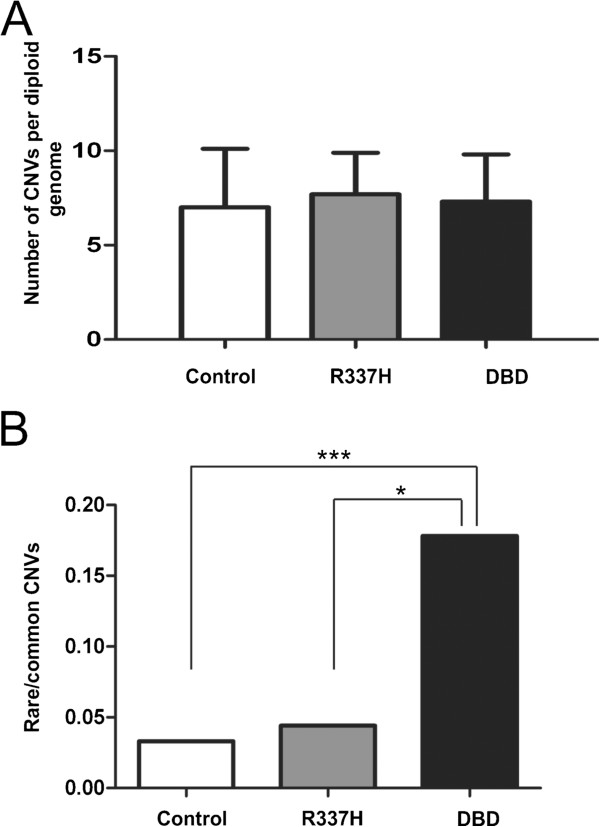
Distribution of CNVs according to TP53 mutation status. The graphs show no differences in the frequency of total CNVs but an increased frequency of rare CNVs in DBD mutation carriers. (A) Frequency of total CNVs in LFS patients and controls; (B) Rare/common CNV ratio in LFS patients and controls. White bar represents the control individuals, grey bar represents p.R337H mutated carriers and dark black bar the TP53 DBD mutated carriers. Fisher-exact test; *p=0.0156 and ***p=0.0002.